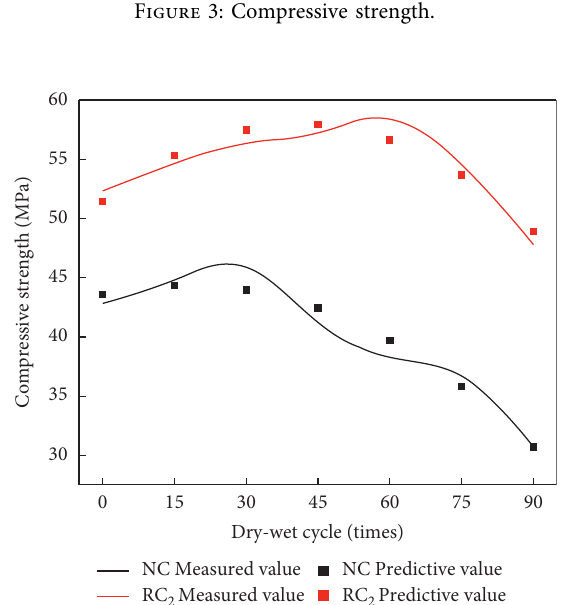
Figure 4: Compressive strength damage evolution fitting